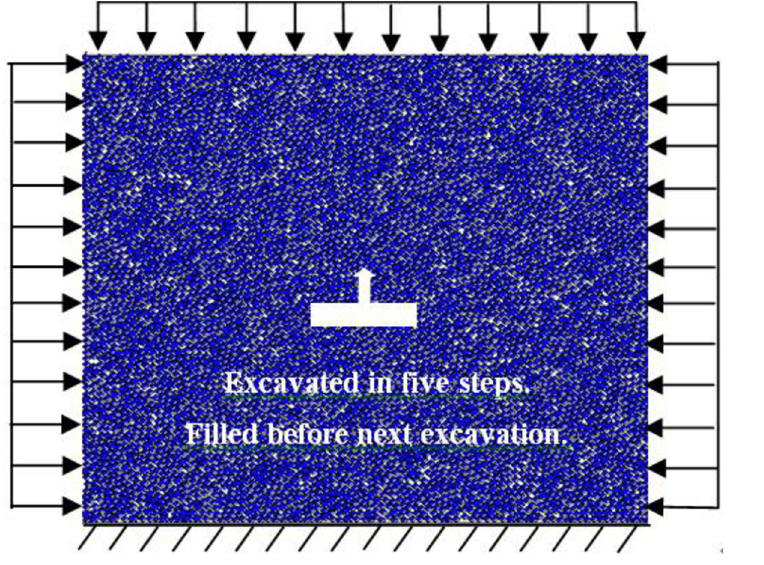
Fig 3. Illustration of the numerical model.